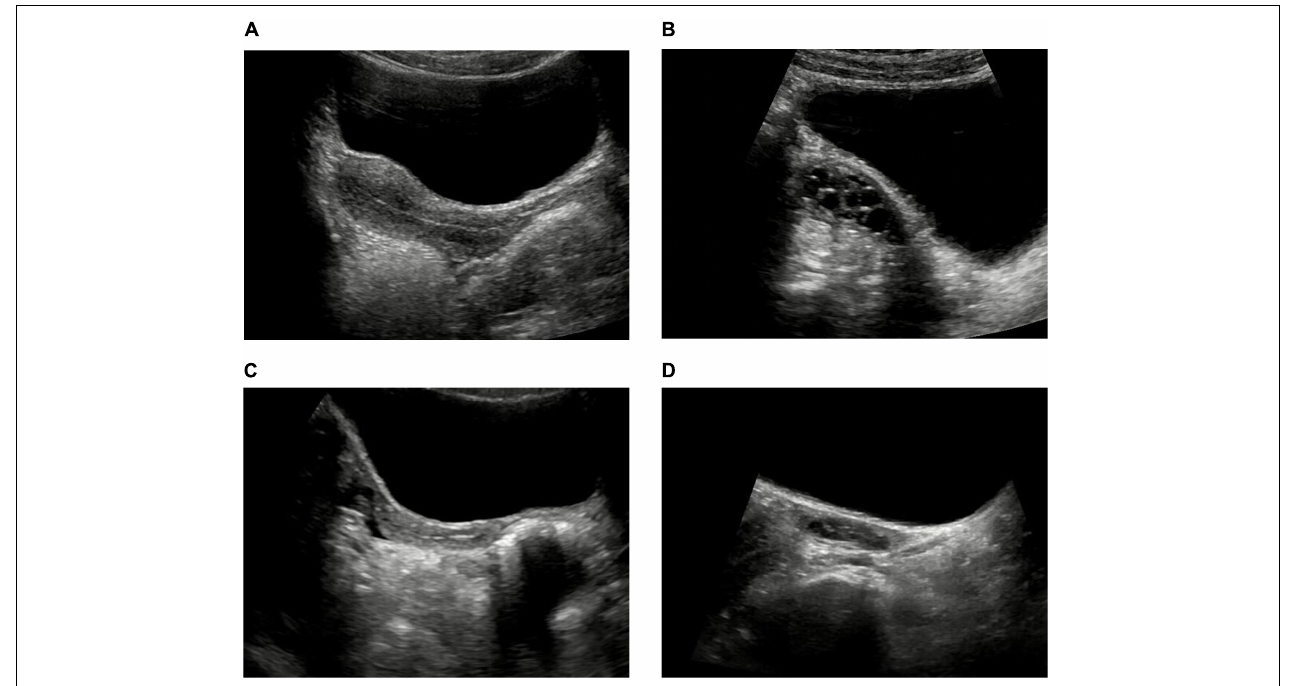
FIGURE 1 | Typical sonograms of the uterus and ovaries of a ICPP patient before and after GnRHa therapy. (A,B) Before GnRHa therapy: the length, anteroposterior diameter, transverse diameter, volume of the uterine body and the ovary, uterine body-cervix ratio were all increased. There were three increased follicles in the ovary, and the maximum diameter of follicle was 8 mm. (C,D) After GnRHa therapy: the length, anteroposterior diameter, transverse diameter, volume of the uterine body and the ovary, uterine body-cervix ratio were all decreased. There was no increased follicle in the ovary. TABLE 3 | Receiver operative characteristic analyses of pelvic ultrasound parameters. Parameter Area under the